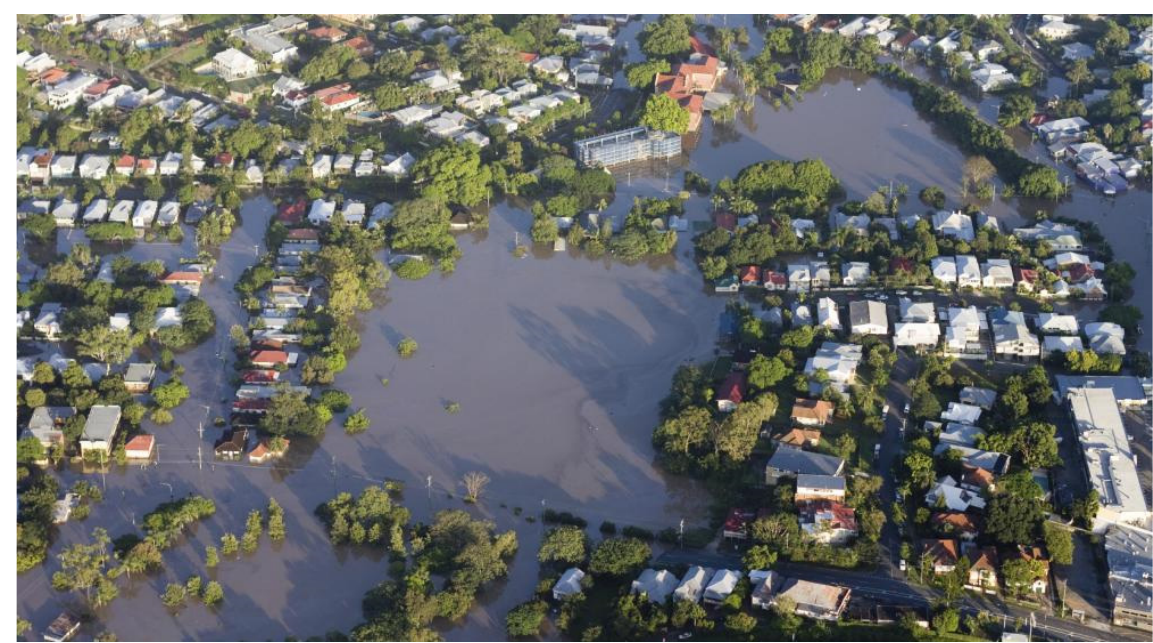
Figure 3. Floods in Brisbane. Wikimedia Commons.